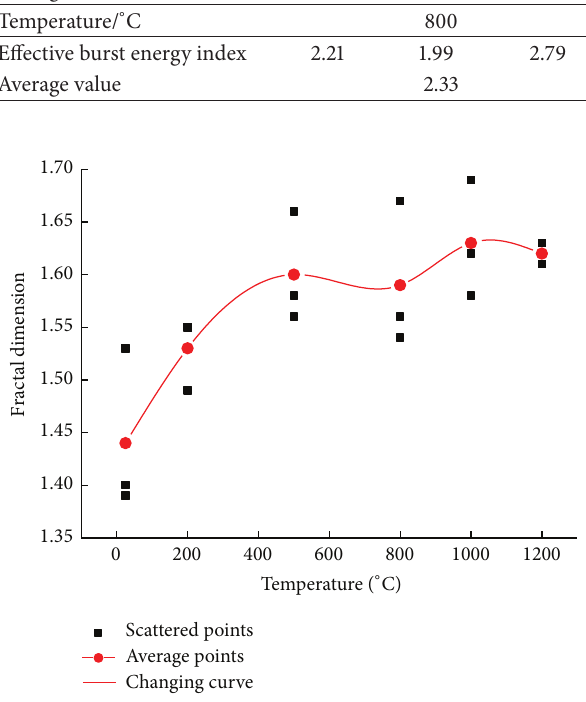
Figure 3: Changes in fractal dimension of fracture surface with temperature.